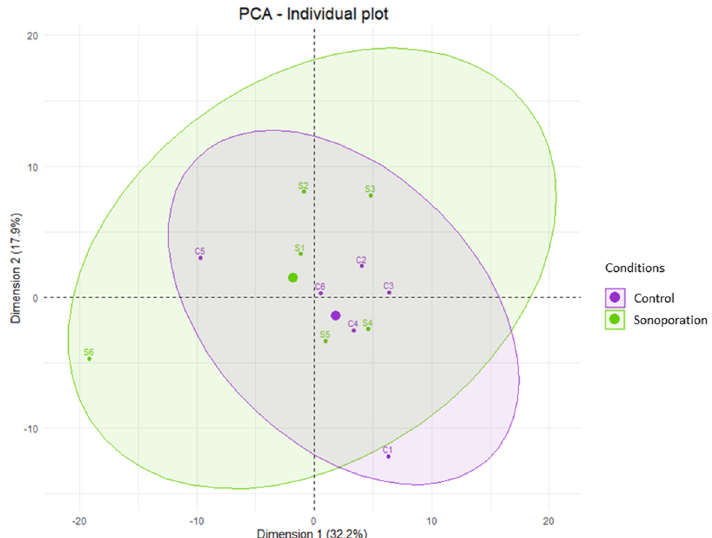
Figure 5. Unsupervised multivariate analysis of perilymph comparing data from sonoporation and control groups. Score-plot of the PCA is shown with adjustment of S1 and C6 data constructed from the metabolites found according to the first two components p1 and p2. The control samples are in purple (C1 to C6) and the sonoporation samples are in green (S1 to S6). Each group is associated with an ellipse regrouping all its samples. The thicker dots correspond to the center of each ellipse. Two samples with the same metabolomic profile appear grouped on this graph (i.e., samples S4 and C4).